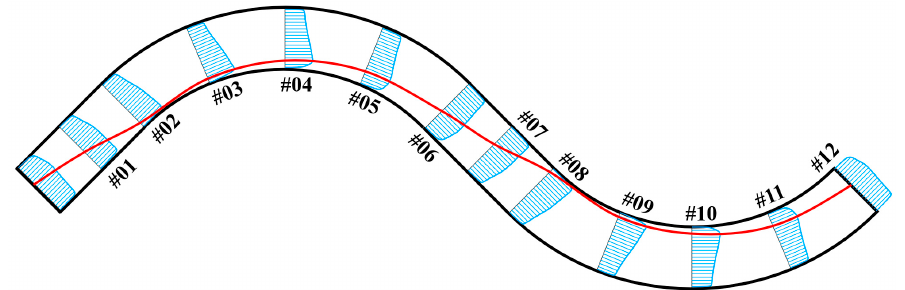
Figure 8. Depth-averaged streamwise velocity U h * distribution along channel in typical cross-sections and the dynamic axis of flow (the solid curve inside the channel).